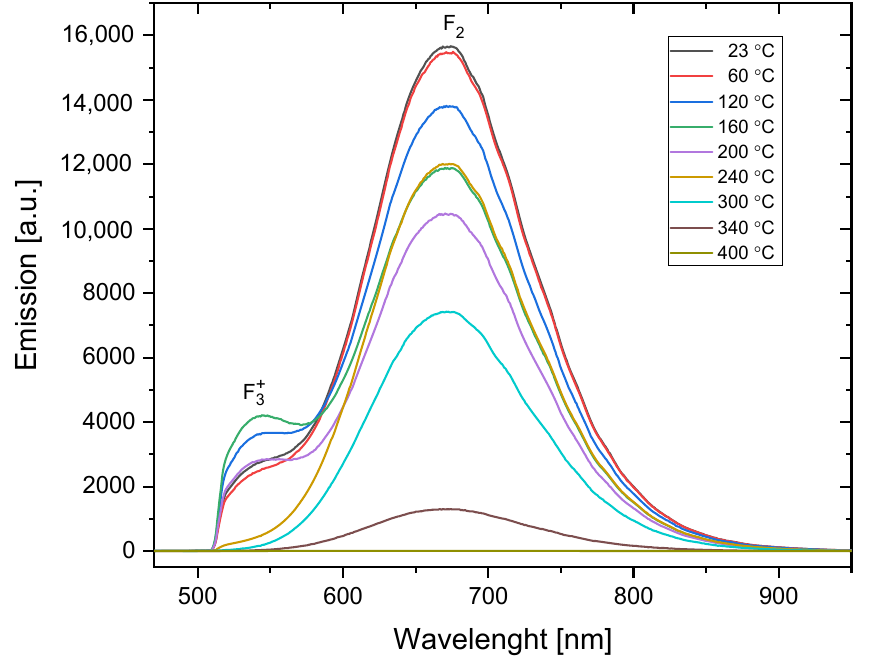
Figure 5. PL emission spectra for the sample irradiated with 30 kGy of beta radiation (Sr-90/Y-90) and submitted to a series of subsequent heat treatments at increasing temperatures (Method 1). Excitation was applied at 440 nm. The bands related to F 2 and F 3 + color centers are marked. Measurements were obtained at room temperature. The spectrum is clipped from the low-wavelength side by the applied filter.